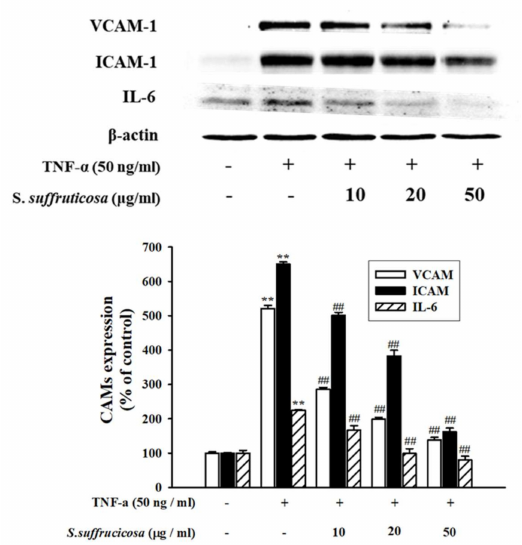
Figure 4. E ff ect of Securinega su ff ruticosa on TNF- α -induced vascular inflammation related molecule expression. The HUVEC were pretreated with Securinega su ff ruticosa for 30 min and followed by stimulation with TNF- α (50 ng / mL) for 24 h. VCAM-1, ICAM-1 and IL-6 protein expressions were analyzed by Western blotting. ** p < 0.01 vs. control, ## p < 0.01 versus TNF- α alone.